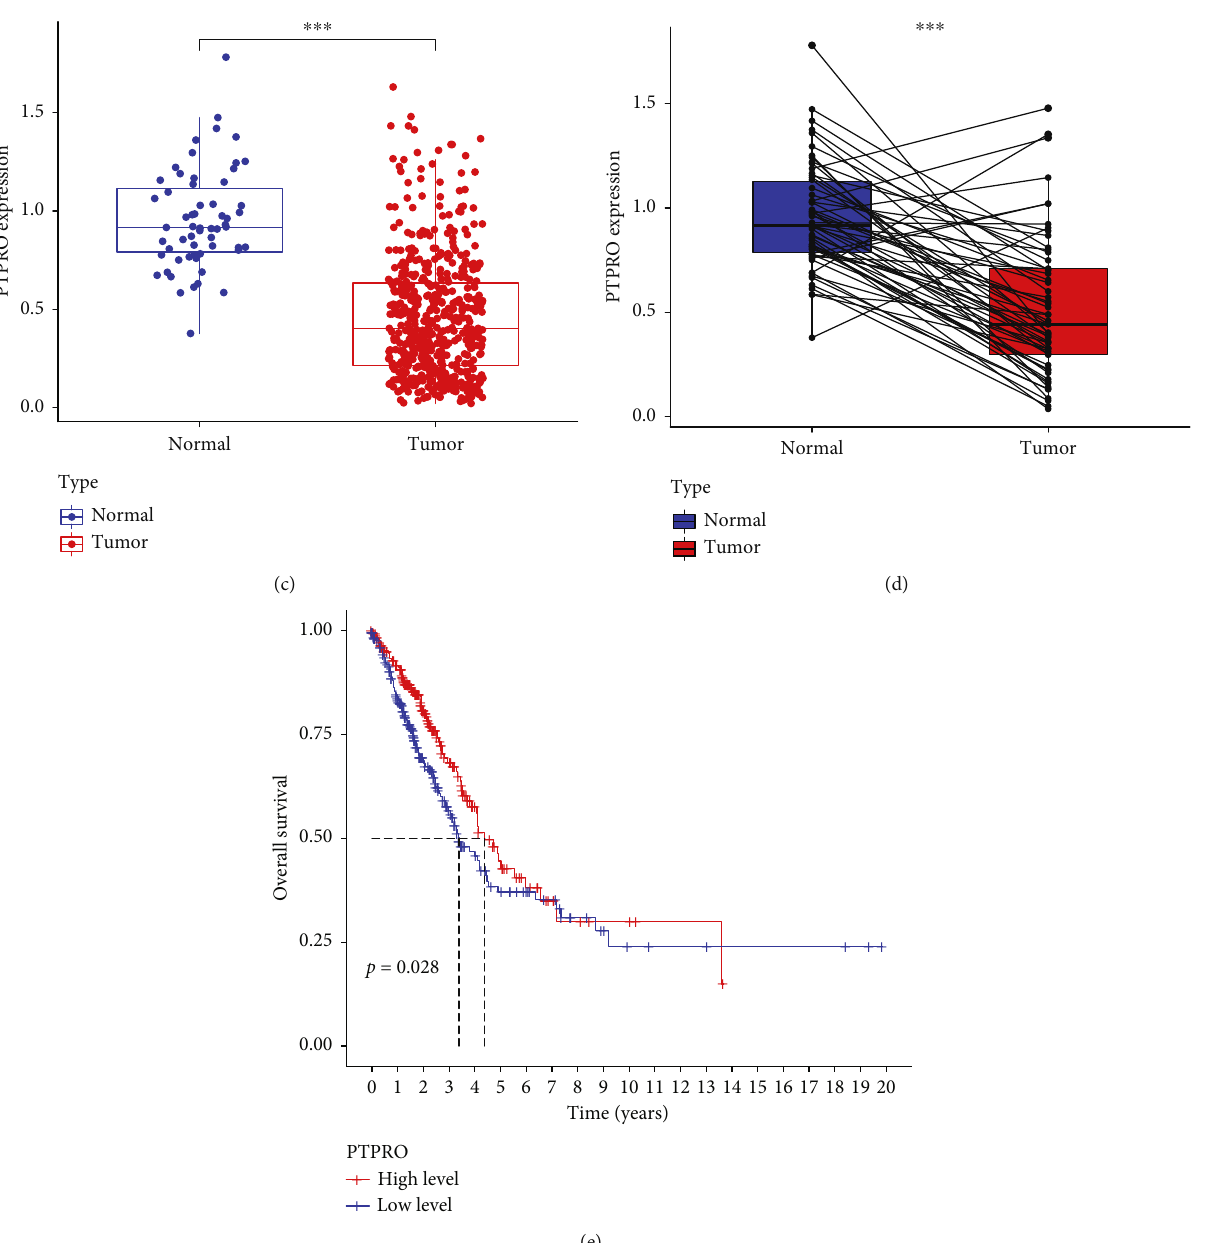
Figure 1: Expression level of PTPRO in LUAD and its correlation with prognosis. (a) Analysis of the expression level of PTPRO in pan- cancer by GEPIA database. (b) Kaplan-Meier survival analysis for high vs. low expression level of PTPRO in LUAD (GEPIA database). (c) Di ff erences in mRNA expression levels of PTPRO in LUAD and normal tissues (TCGA database). (d) Di ff erences in mRNA expression levels of PTPRO in LUAD and paired normal tissues (TCGA database). (e) Kaplan-Meier survival analysis for high vs. low expression level of PTPRO in LUAD (TCGA